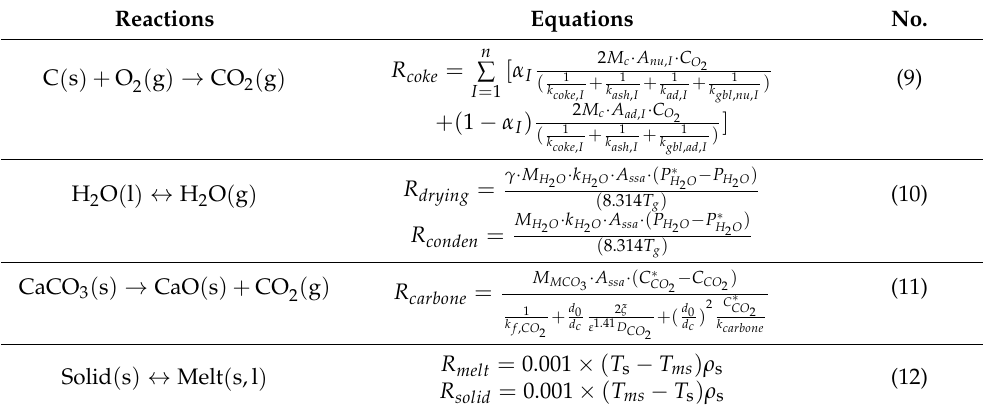
Table 2. The reaction rate equations of the sintering process. Reactions Equations